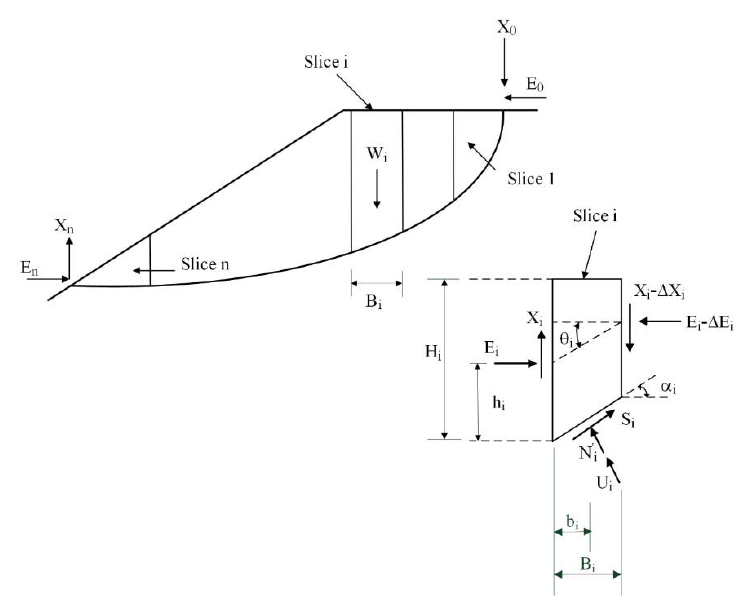
Figure 11. Forces acting on vertical slice of potential failure mass (Janbu’s slice method).